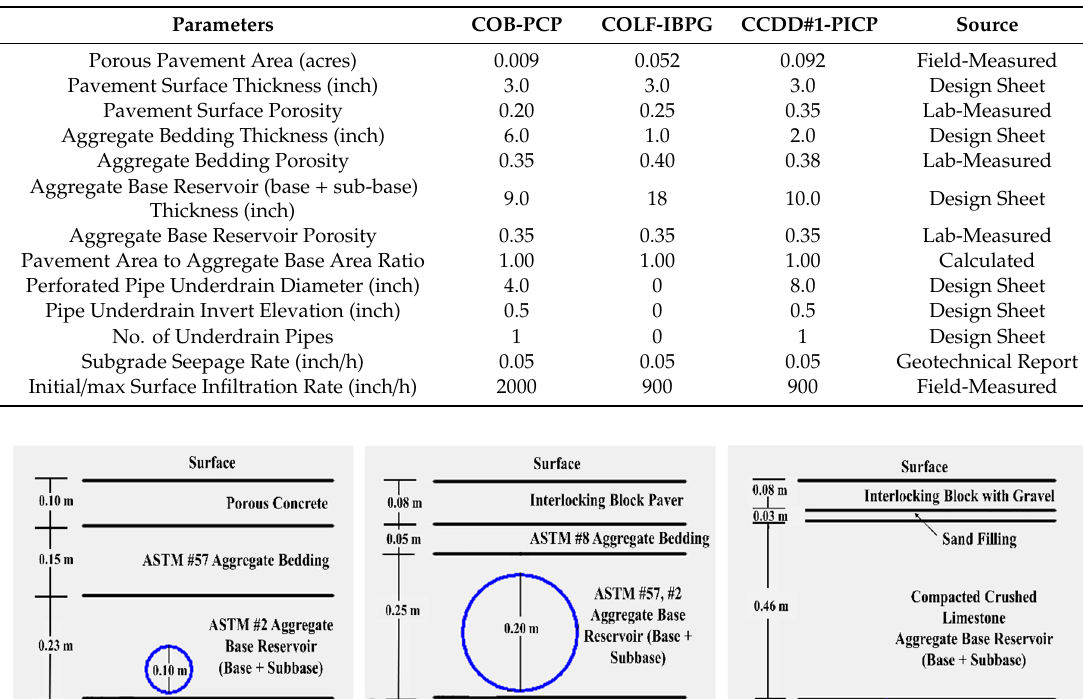
Figure 2. Delineation of flow routing schematic (including land use, conduits, junctions, outfall, and permeable pavement subroutine) for incorporation into the Source Loading and Management Model for Windows (WinSLAMM). Table 2. Initialization of WinSLAMM model input for permeable pavements subroutine for three di ff erent designs.